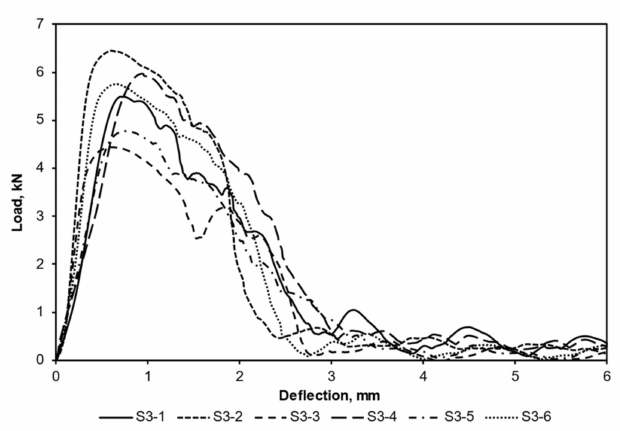
Figure 6. Examples of load–deflection curves recorded during the compression tests of S3. Each test was terminated once a full thread stripping